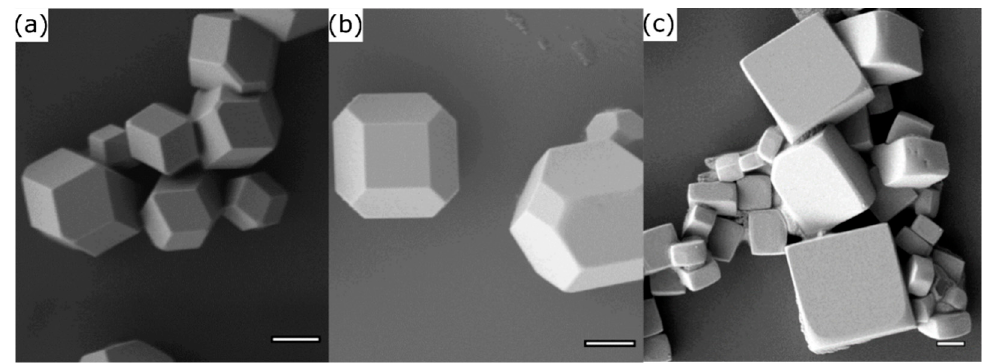
Figure 3. SEM images of the (a) RD microcrystals, (b) ECC microcrystals formed using an 30% excess of CH 3 NH 3 Br, and (c) CU microcrystals using an 80% excess of CH 3 NH 3 Br; scale bars = 1 μ m.